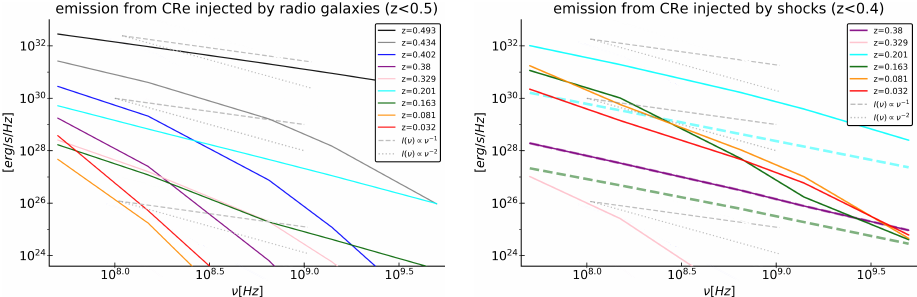
Figure 9. Comparison of the evolving radio emission spectra from our simulation form the two investigated scenarios for the origin of cosmic ray electrons (without considering observational cuts). ( Left panel ): emission from electrons seeded by radio jets at z = 0.5 (CST model). ( Right panel ): emission from electrons seeded by merger shocks, starting from z = 0.4 (CST model). The additional thick dashed lines show the radio emission only coming from electrons freshly injected by shocks at the epoch of observation (these lines are only visible for the snapshots with enough ongoing shock acceleration. The repeated thin grey dotted lines give two different radio slopes ( I ( ν ) ∝ ν − 1 and ∝ ν − 2 ) to guide the